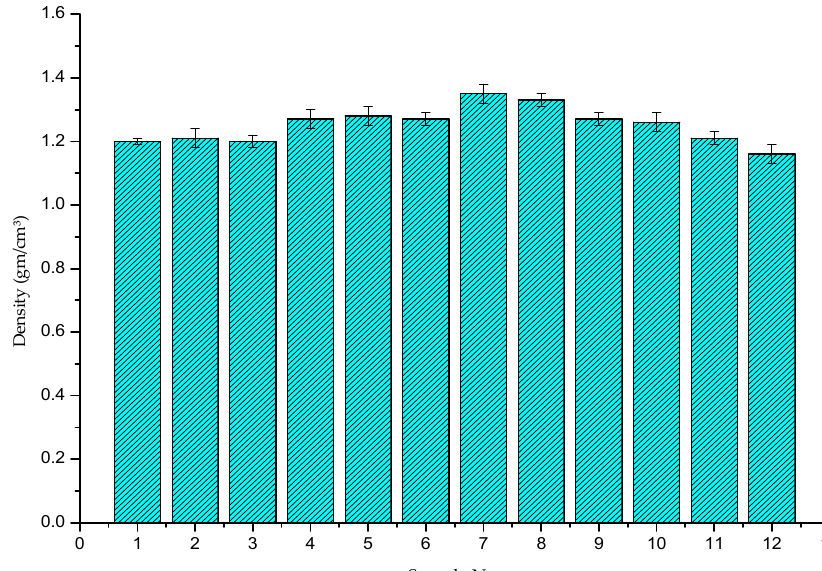
Figure 7. Densities of composite